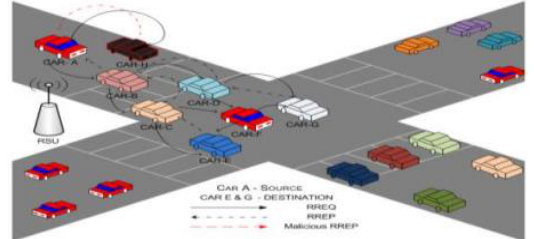
Figure 3. Black Hole Attack in VANET(Upadhyaya